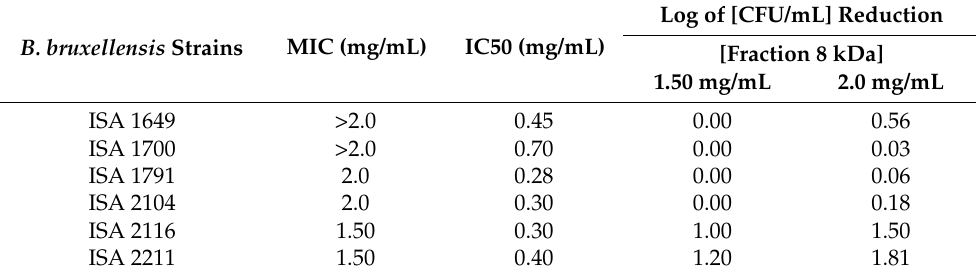
Table 3. Minimum inhibitory concentration (MIC), half-inhibitory concentration (IC50) and bio- cidal effect (determined as Log of [CFU/mL] reduction) of fraction 8 kDa determined against six B. bruxellensis strains.